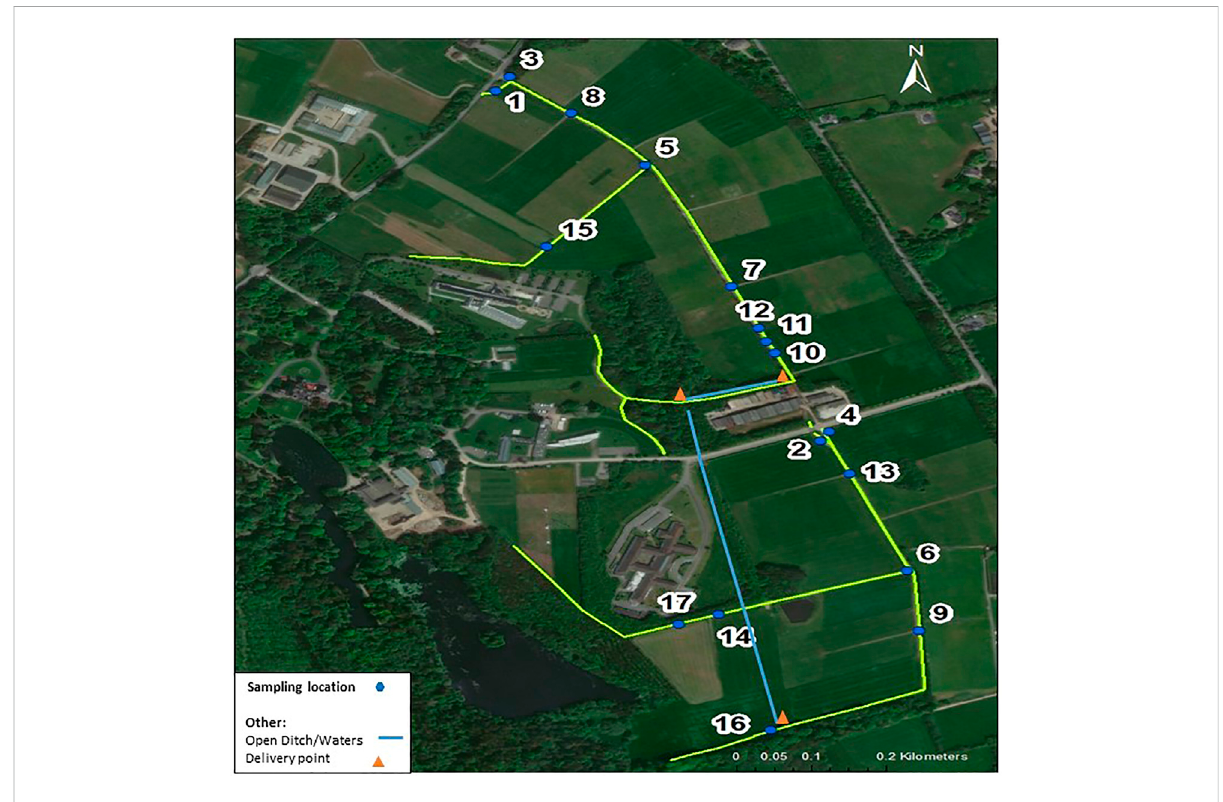
FIGURE 1 Roadway network and sampling